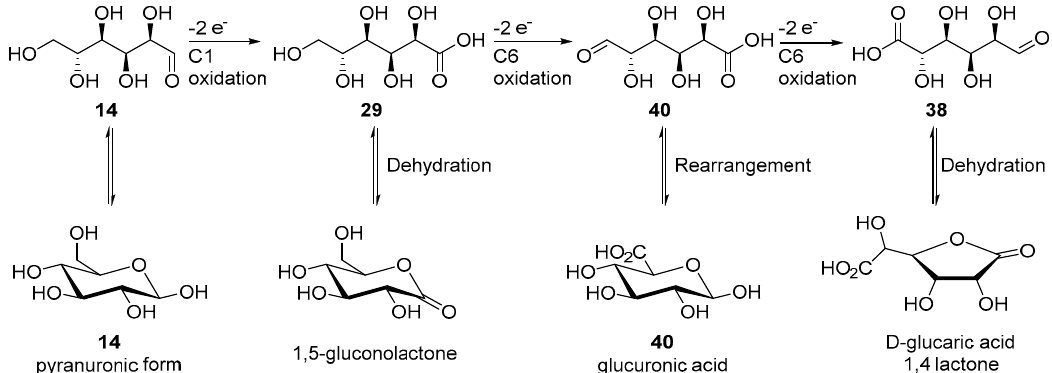
Table 8. Summary of the direct electro-oxidation of